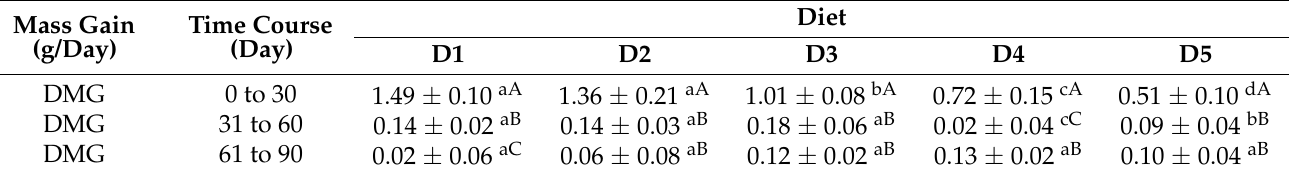
Figure 1. Cumulative mass gain of Zophobas atratus larvae fed a conventional diet with or without grape residue for 90 days, respective trend line equations, and regression determination coefficients (R 2 ). Diets: D1 = 100% 70 g/100 g poultry feed and 30 g/100 g ground maize mixture (control); D2 = 75% D1 + 25% D5; D3 = 50% D1 + 50% D5; D4 = 25% D1 + 75% D5; D5 = 100% grape juice production residue. Different letters indicate significant differences by Tukey’s test ( p ≤ 0.05; n = 3). Table 2. Daily mass gain of Zophobas atratus larvae fed a conventional diet with or without grape residue from zero to 30, from 31 to 60, and from 61 to 90 days of